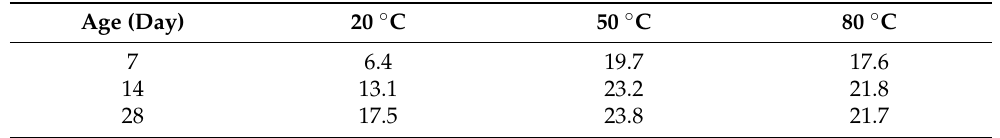
Table 5. Enthalpy changes in M-S-H recrystallization between 800 °C and 860 °C calculated from Figure 12 Δ H/(J·g − 1 ).